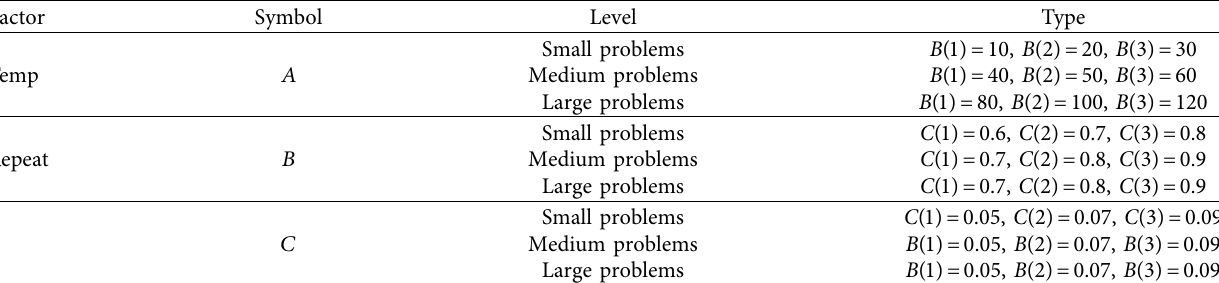
Table 2: Operators, parameters, and their levels (GA).